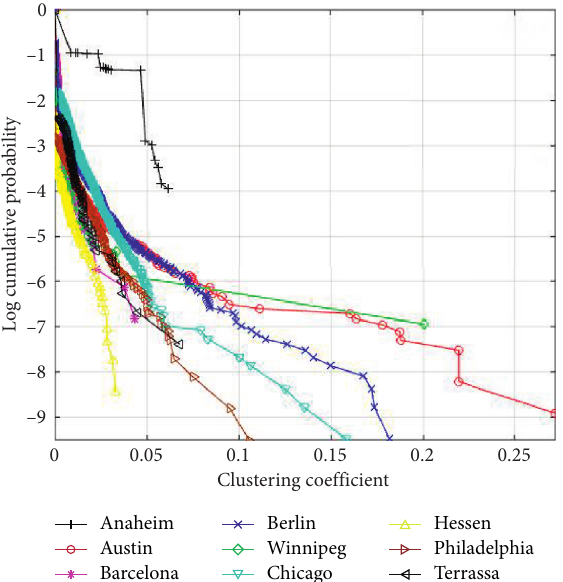
Figure 3: Clustering coefficient of